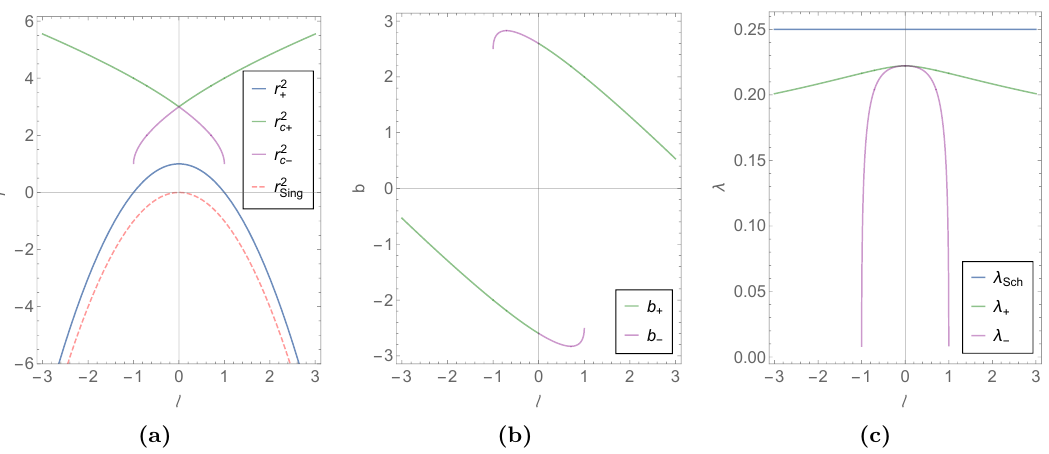
, in blue the values of r 2 , In green and purple the Figure 3. (a) In red the maximum values of r 2 + sing values of r 2 and r 2 respectively. (b) In green and purple the values of b c, + and b c, − respectively. c, + c, − (c) In green and purple the values of λ + and λ − respectively. In all plots we set M = 1 and ‘ 1 = 0 . 8 .